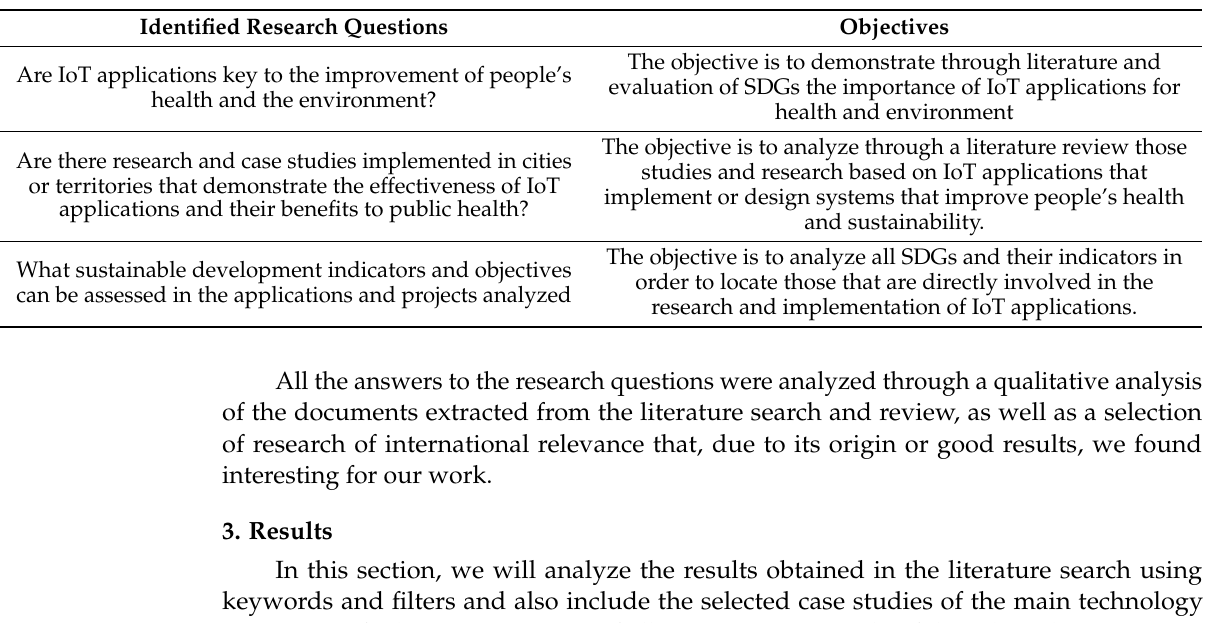
Table 3. Identified research questions and their